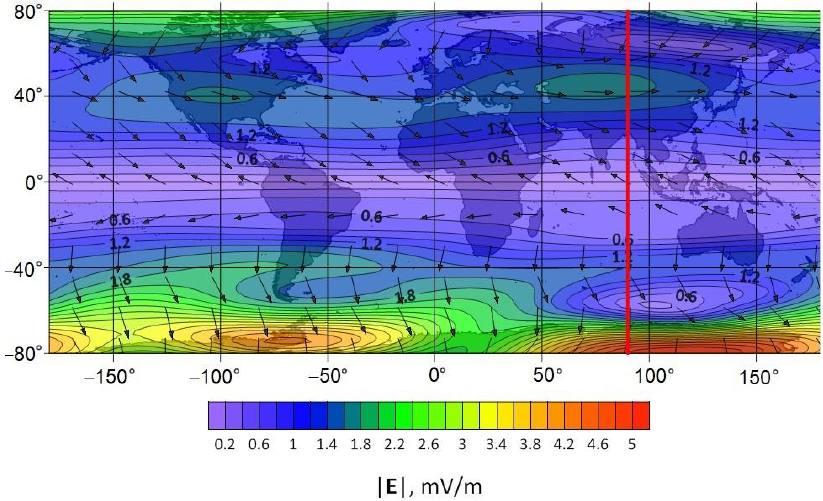
Figure 12. Background electric dynamo field in the ionosphere. The red vertical line shows the position of the subsolar meridian.